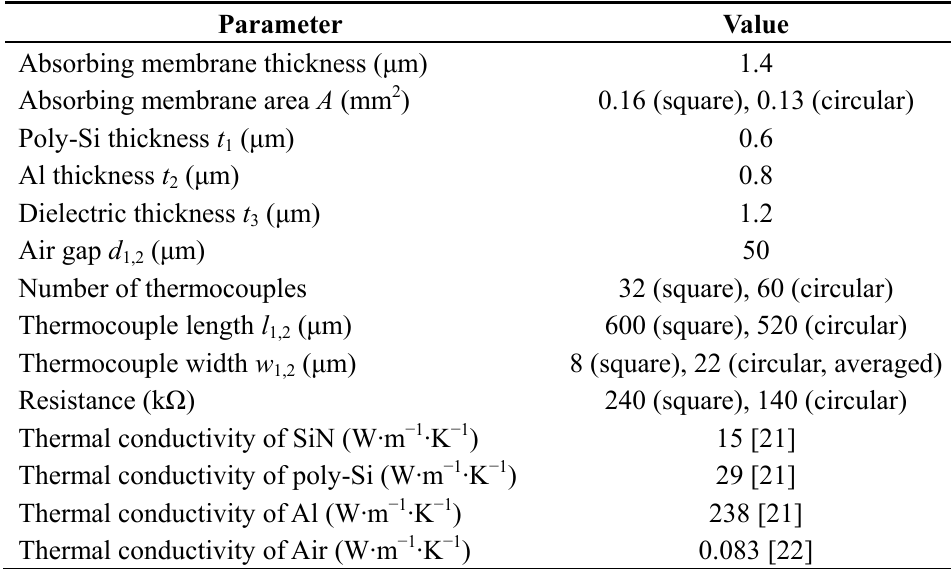
Table 3. Structure parameters and material properties of the designed thermoelectric infrared